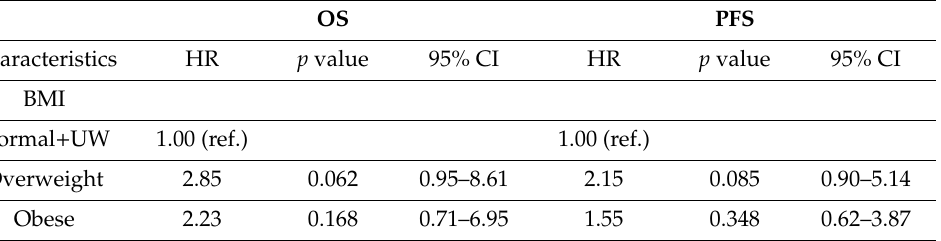
Table 2. Univariate analysis HR (95% CI) of OS and